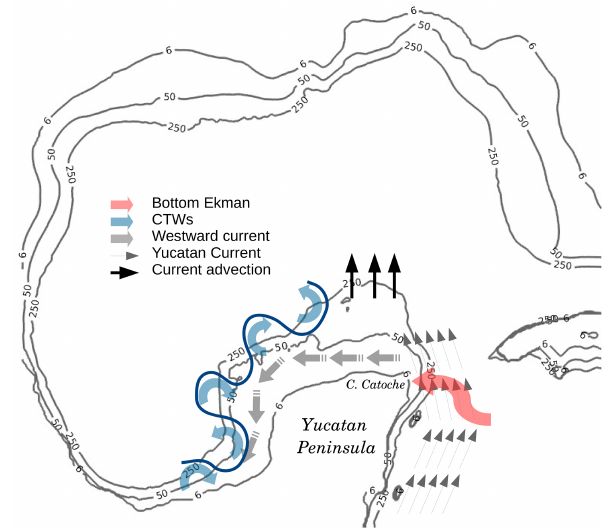
Figure 16. Schematic view of the main physical processes that modulate the cross-shelf transport of TN in the Yucatán